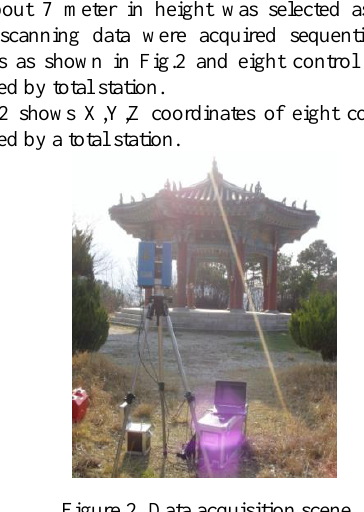
Figure 4. 3D modelling of the pavilion